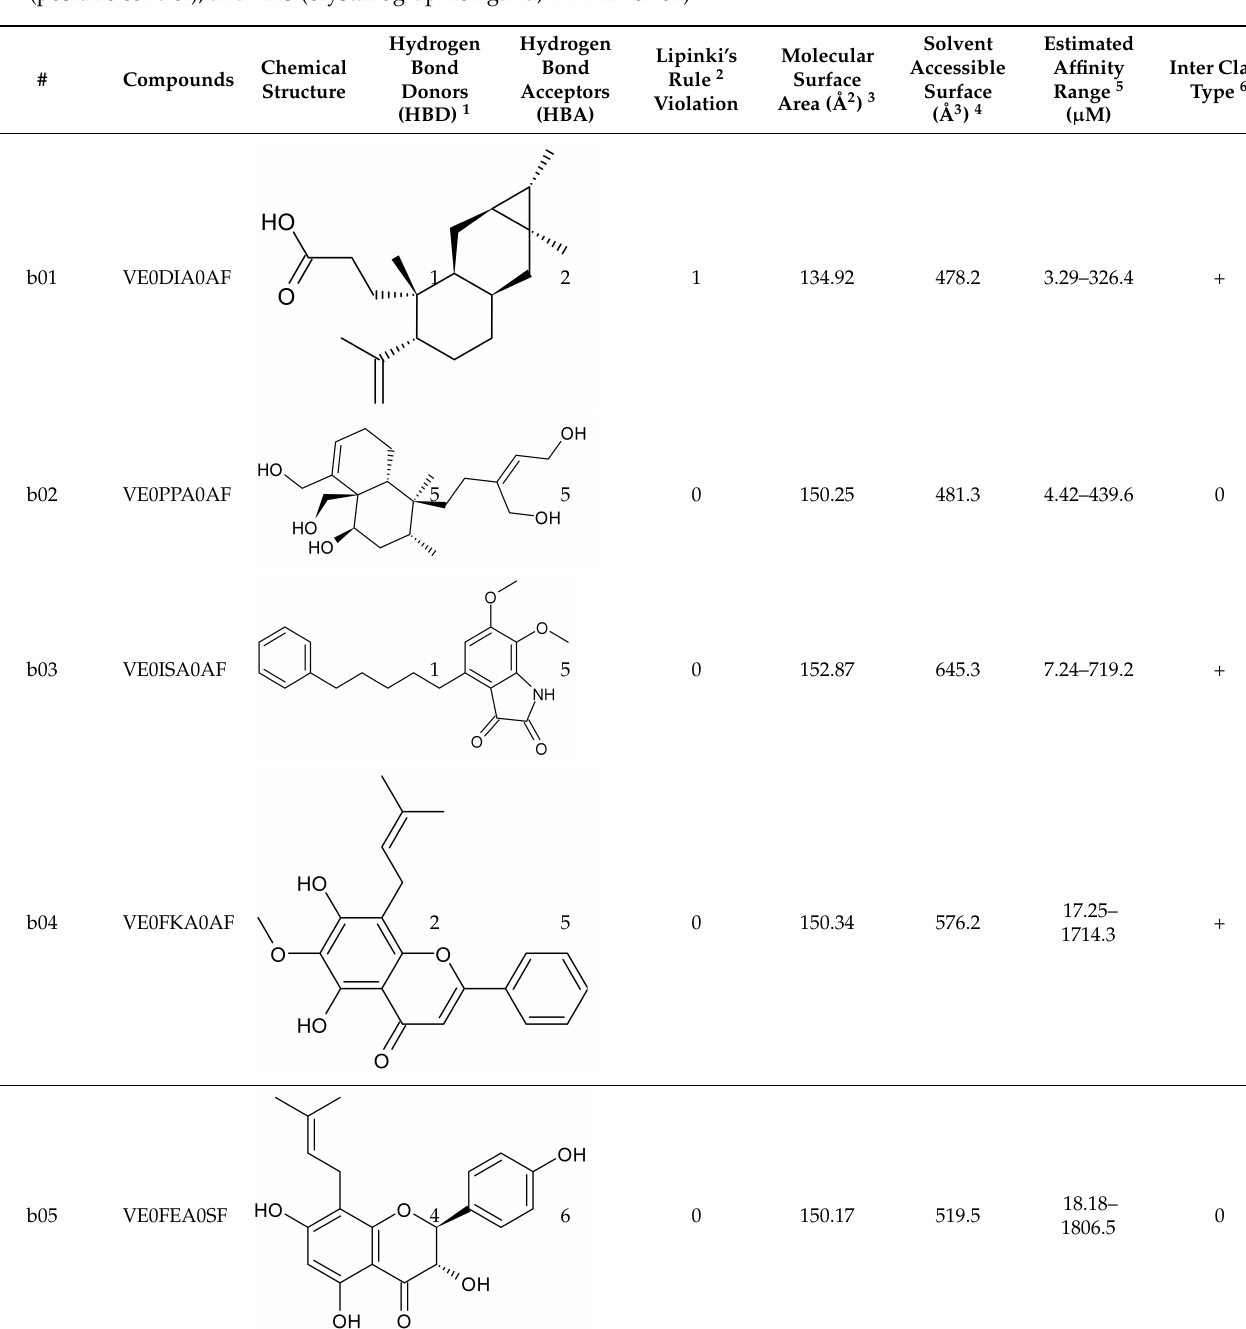
Table 1 instead of 46 NatProDB and E-64 molecules as previously filtered from the ADMET analysis (see preceding discussions). Table 1. Best docking results carried out by SeeSAR version 9.2 (BioSolveIT GmbH) on the active site of the SARS-CoV-2 main protease (SARS-CoV-2 Mpro) using the Natural Products Database of the Bahia Semi-Arid region (NatProDB), E-64 (positive control), and RZS (crystallographic ligand, PDB ID: